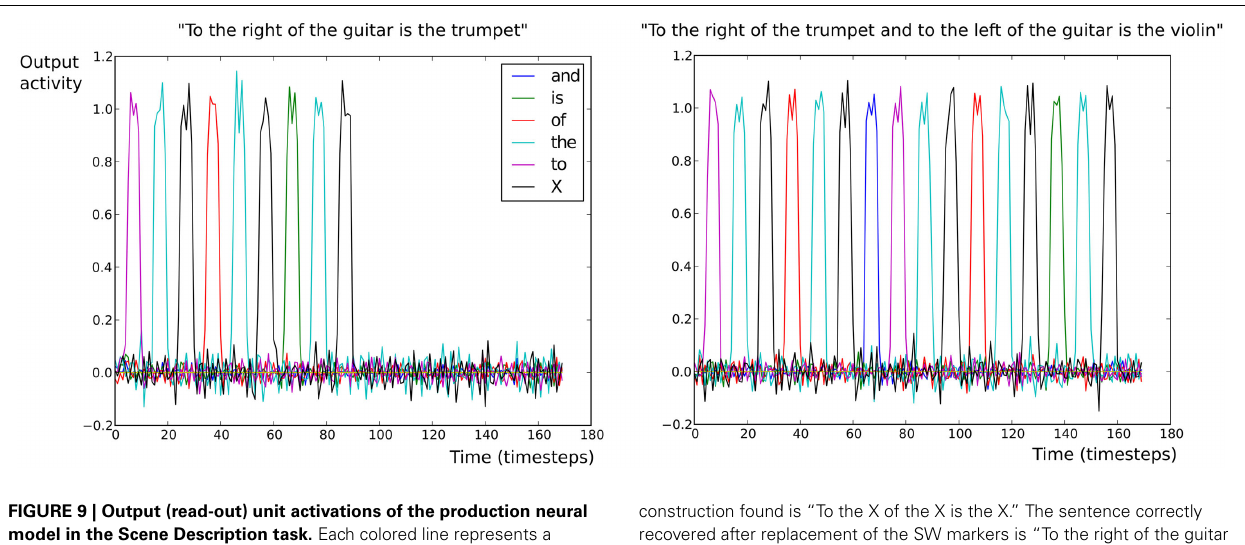
construction found is “To the X of the X is the X.” The sentence correctly recovered after replacement of the SW markers is “To the right of the guitar is the trumpet.” (Right) The construction found is “To the X of the X and to the X of the X is the X.” The sentence correctly recovered after replacement of the SW markers is “To the right of the trumpet and to the left of the guitar is the